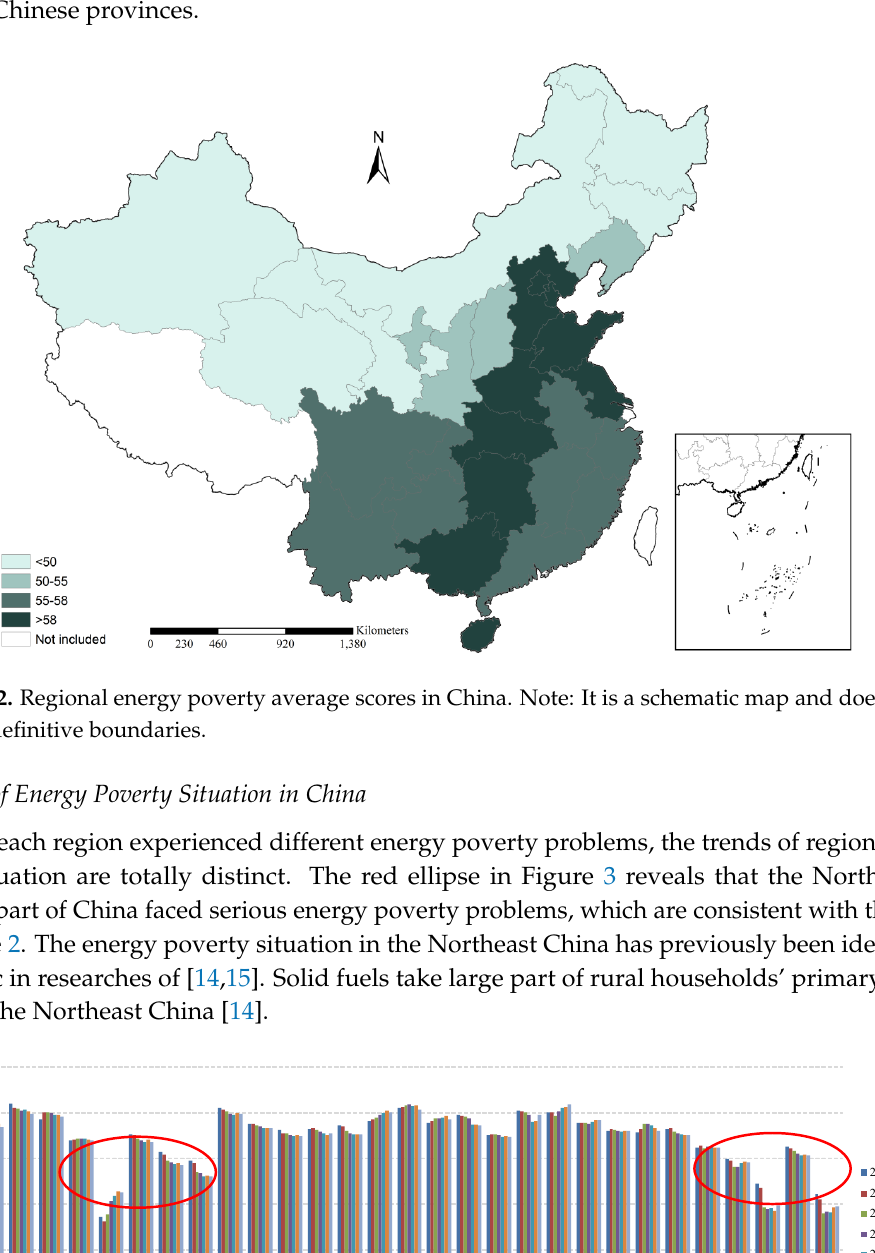
Figure 4. Changes of regional energy poverty situation in China. Note: It is a schematic map and does not imply definitive boundaries. 3.3. Influencing Factors for Energy Poverty Alleviation Actually, energy poverty is an issue of energy development. This paper chooses six factors that are relevant for energy poverty, which are closely related to energy development. Each parameter